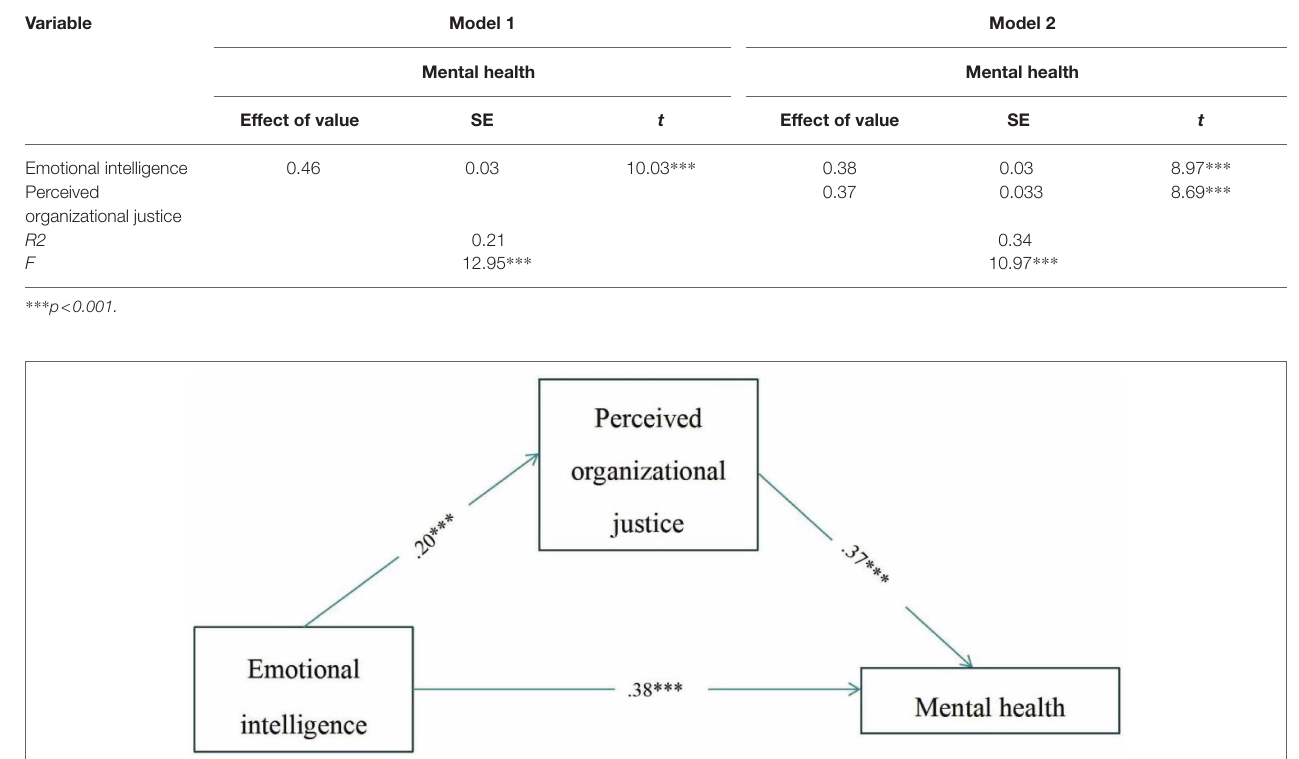
FIGURE 1 | The model of emotional intelligence, perceived organizational justice (POJ), and mental health.